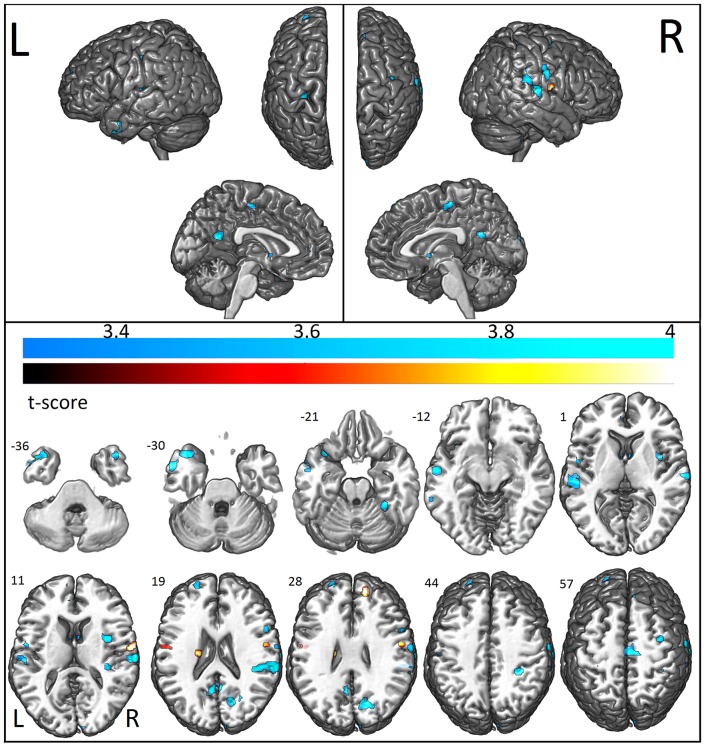
Areas with decreased (cool colormap) and increased (hot colormap) functional connectivity measurements in patients when compared to controls. In shades of blue (cool colormap), regions with maximum decreased functional connectivity (union of all seeds results, two sample t-test p < 0.001 clusters with at least 10 voxels) in patients compared to controls. In the hot colormap (black to yellow), regions of increased functional connectivity (two sample t-test, p < 0.001, cluster with at least 10 voxels).